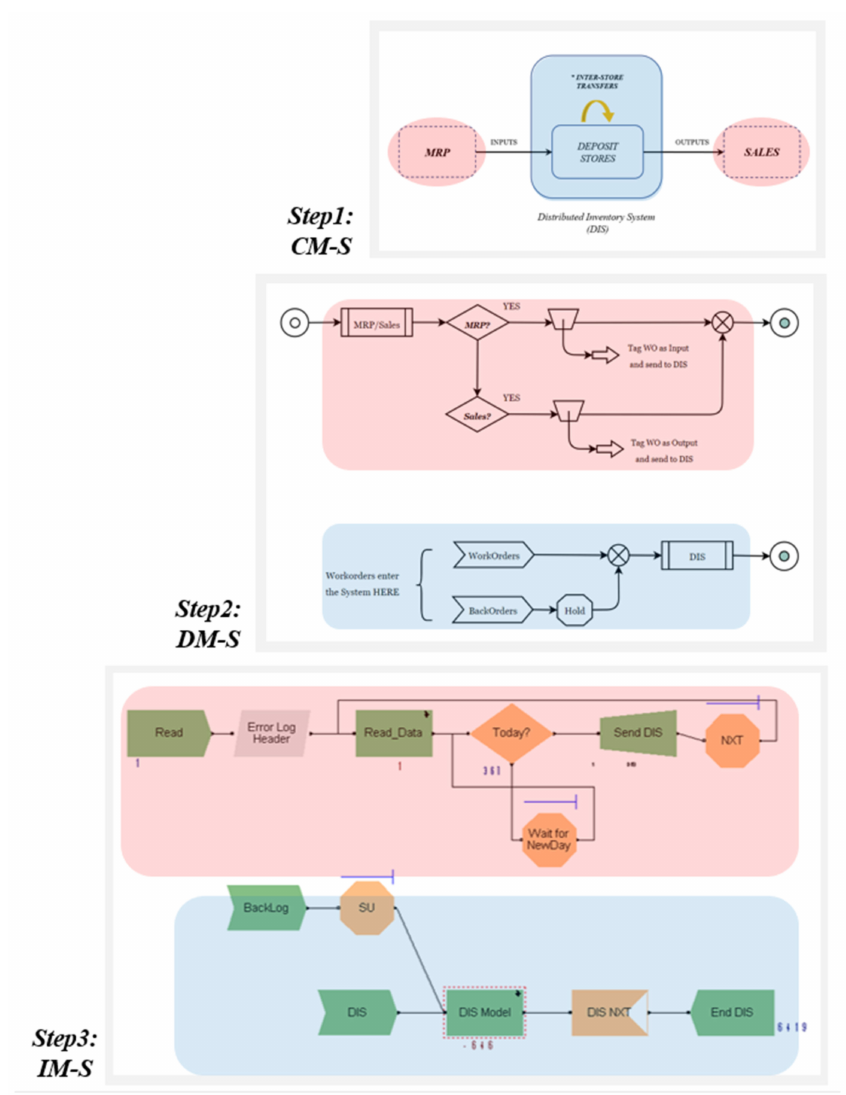
Figure 23. Conversion of CM-S to DM-S (detailed in Figures 17 and 20) and finally into IM-S. System elements are highlighted in blue and environmental actors in